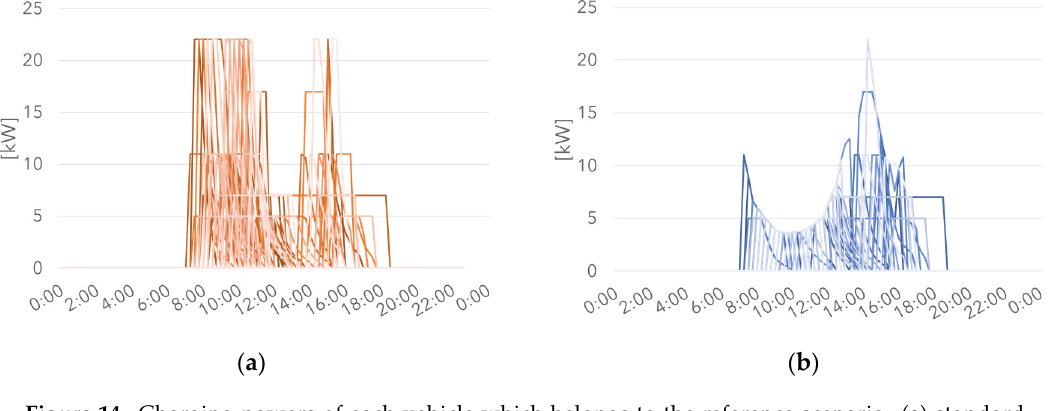
Figure 14. Charging powers of each vehicle which belongs to the reference scenario: ( a ) standard (No-CMS) charging; and ( b ) stand-alone CMS (SA-CMS) charging.